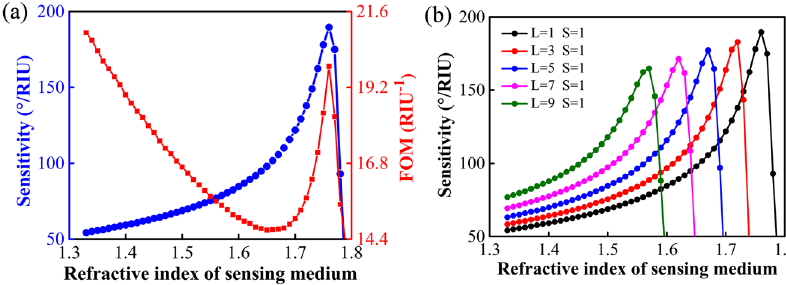
Figure 4: (a) Sensitivity and figure-of-merit (FOM) change with the refractive indices (RIs) of sensing targets where the thickness ofsilicon(Si)filmsis14nm,andthenumber of the black phosphorus (BP) and graphene layers is L = 1 and S = 1, respectively; (b)sensitivitychangeswithBPlayerswhere the thickness of Si fi lms is 14 nm, and the number of graphene layers is S = 1.